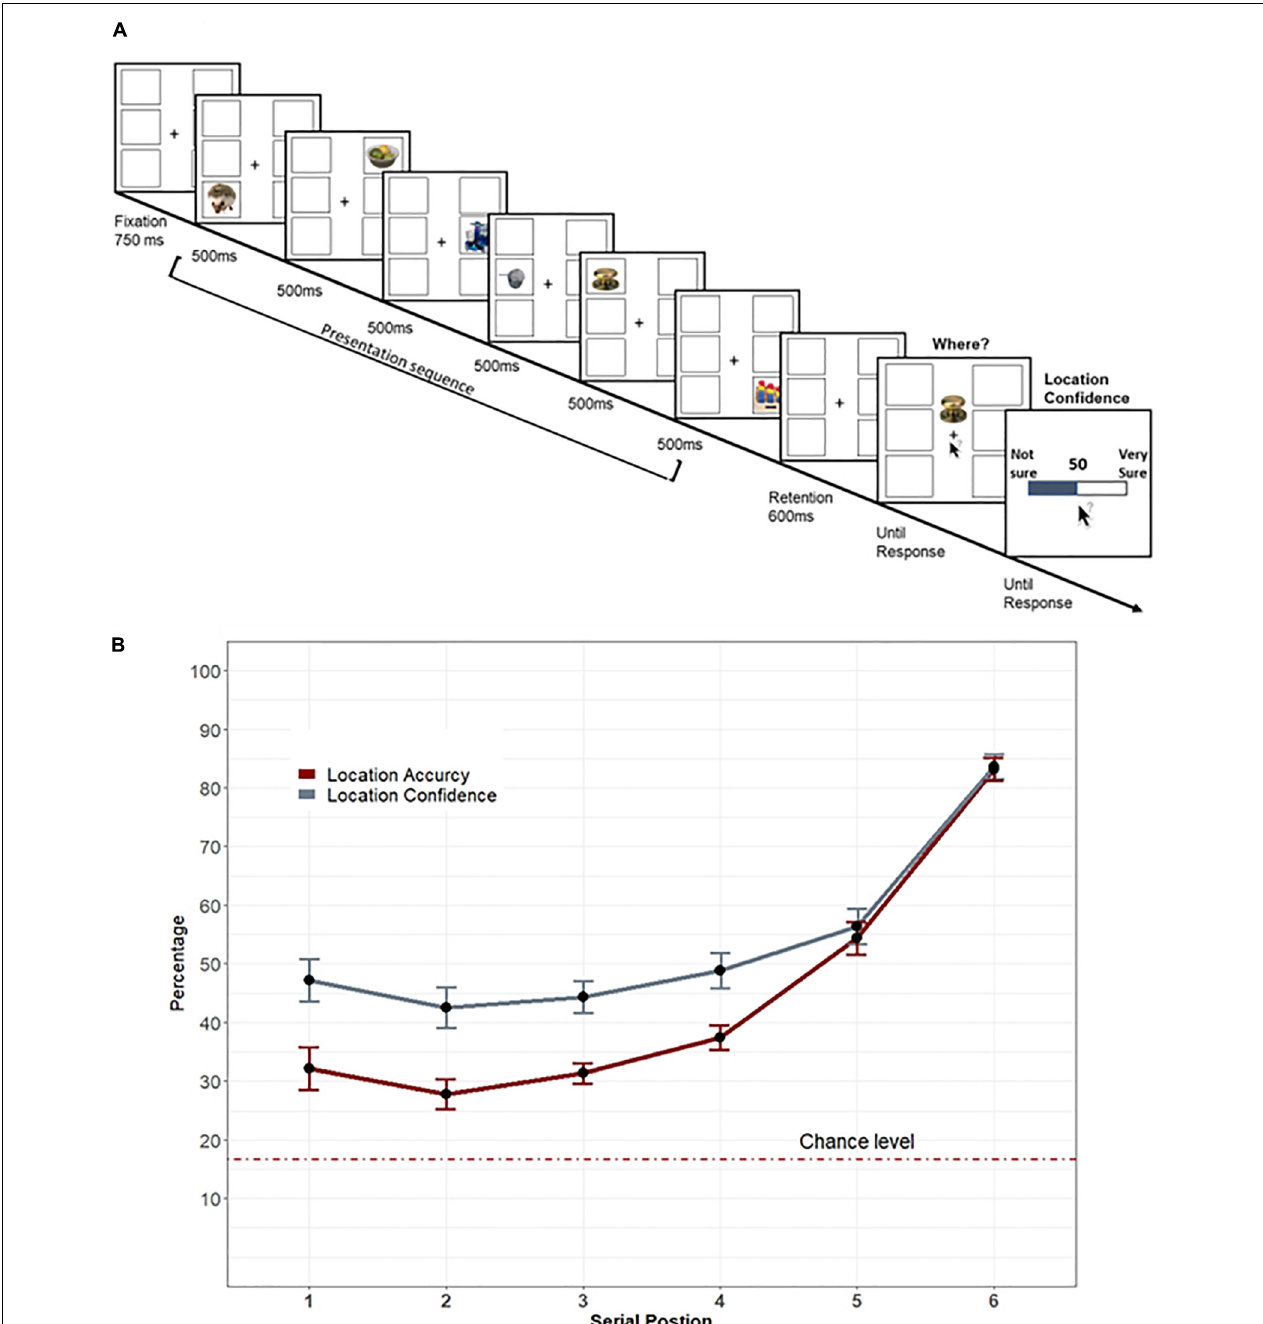
FIGURE 1 | (A) Illustration of Experiment 1’s trial’s sequence: Each trial began with blank place-holders. The presentation sequence consisted of six items, each at a distinct location. After the final stimulus and between the presentation of the probe, a blank place-holders display was shown for 600 ms. Following this short retention, participants were asked to indicate where the probed item appeared and to rate their confidence regarding their response. (B) Experiment 1’s results: Mean confidence (gray line) and the mean percentage of correct location (red line) plotted as a function of the probed-item’s serial position during the presentation sequence. Error bars represent standard error of the